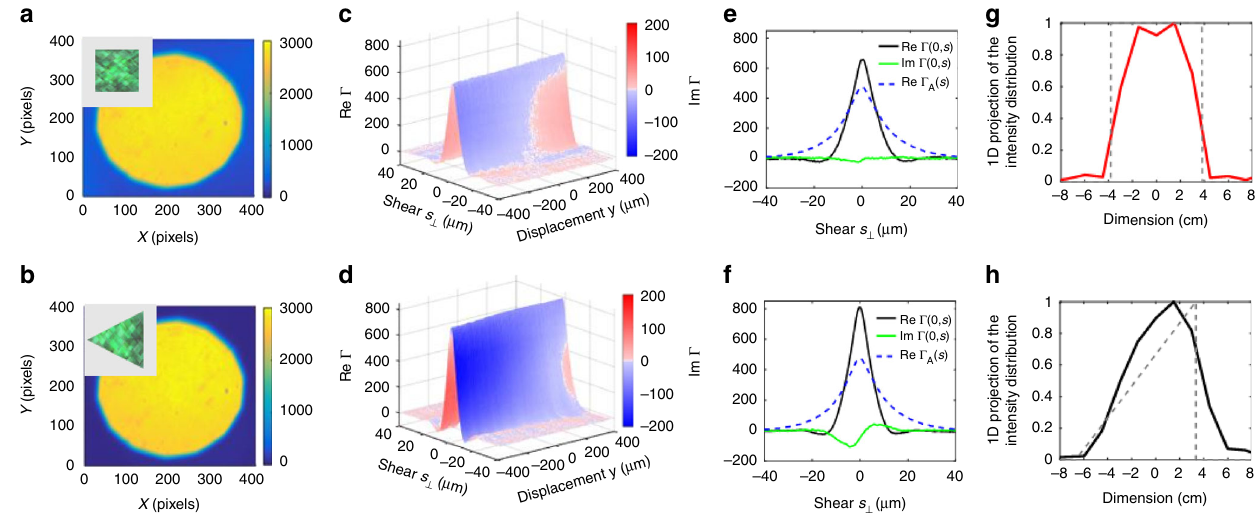
Fig. 5 Shape recovery from coherence measurements. a , b The intensity distribution across the DuPSaI fi eld of view corresponding to the square and equilateral triangle objects, respectively. c , d Plots of real and imaginary components of SCF measured for the square and equilateral triangle objects, respectively. The imaginary component is color coded and superposed on the 3D representation of the real part of SCF. e , f Variations of real and imaginary SCF components at y = 0. The corresponding apodizing function Γ A ( s ) is also indicated by dashed lines. g , h The 1D projection of the intensity distributions recovered from SCF measurements (solid lines) together with the actual intensity pro fi les evaluated across the targets (dotted